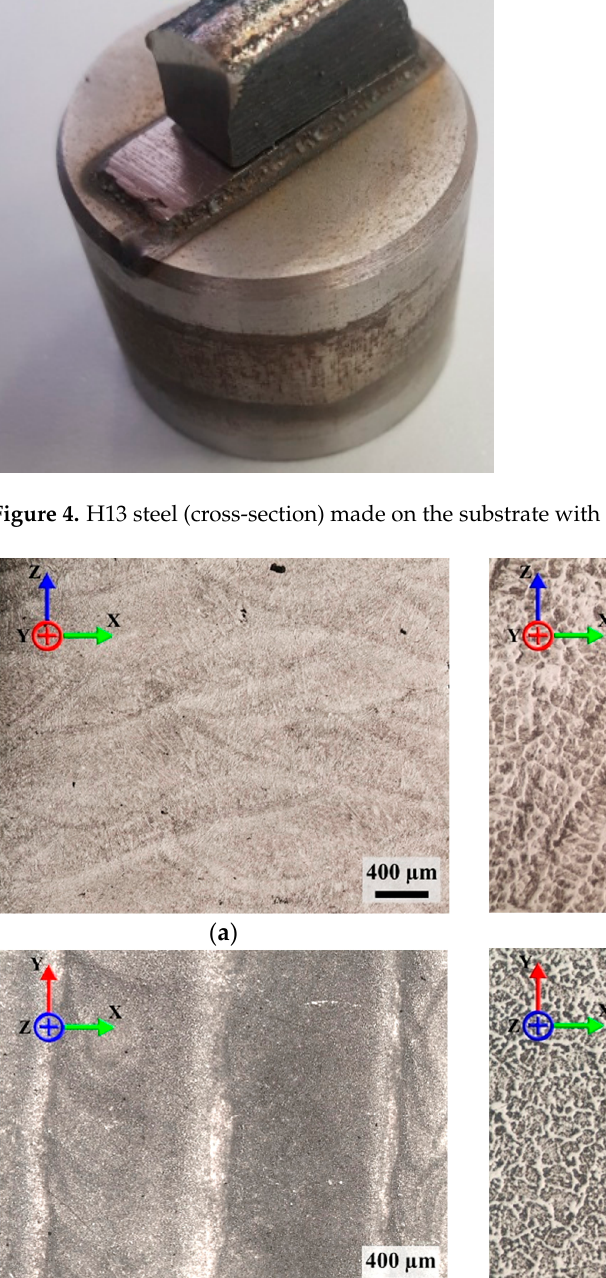
Figure 5. Microstructure of the original H13 steel sample L-DED manufactured without US, where ( a ) and ( b ) are the perpendicular direction ( Y ), in line with the building direction, and ( c ) and ( d ) are the longitudinal direction ( X ).